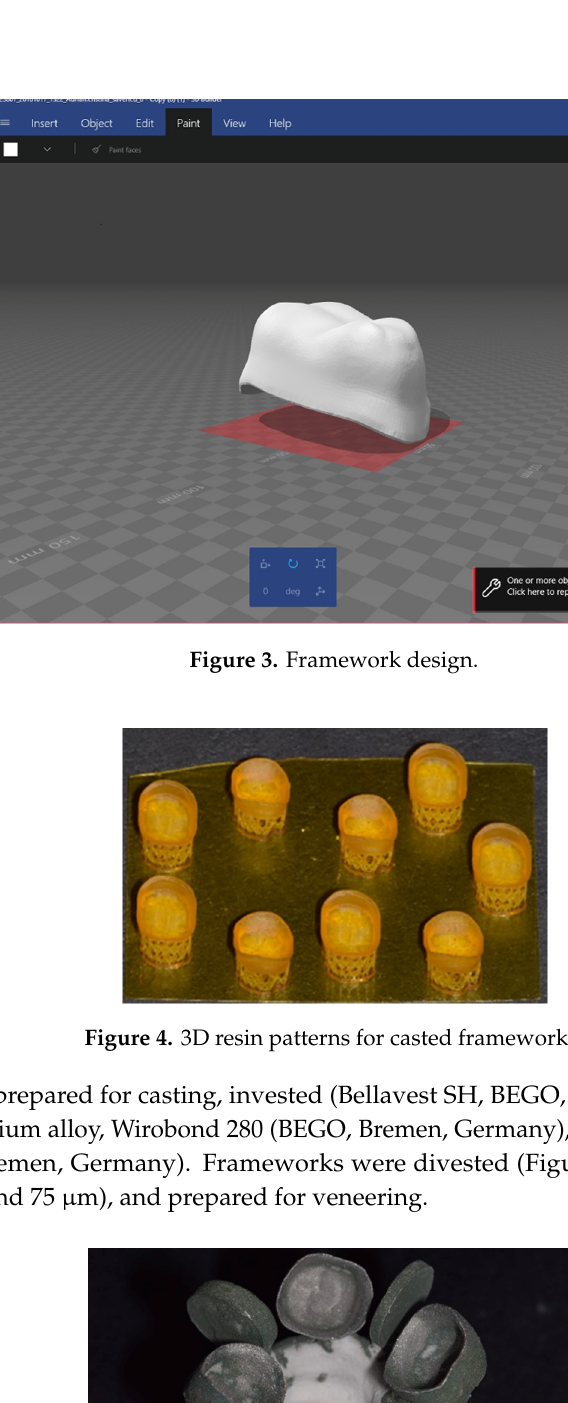
Figure 4. 3D resin patterns for casted frameworks.